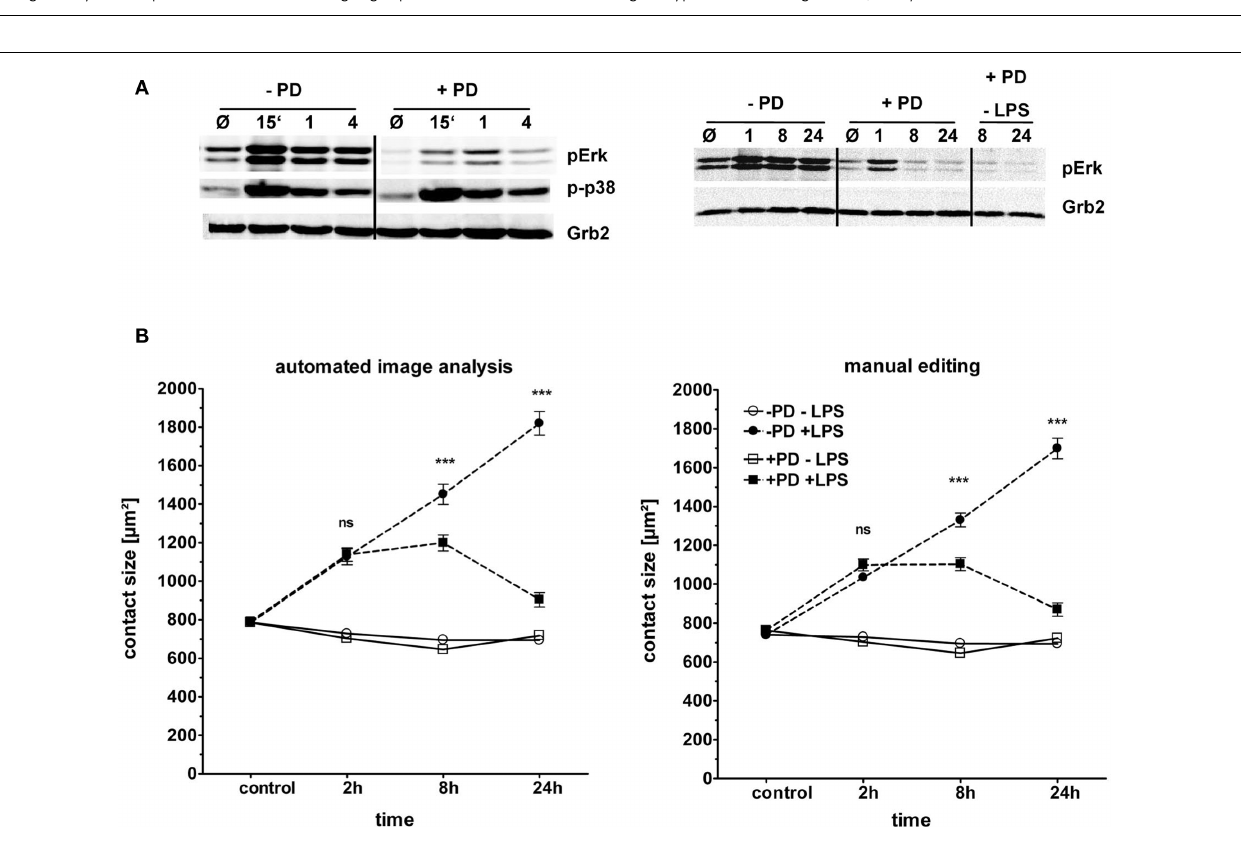
FIGURE 5 | Phenotype of Myd88 − / − macrophages in cell spreading. BMM from Myd88 ± and Myd88 − / − mice were plated and stimulated as described in Figure 3 . Macrophage spreading was analyzed by automated image analysis (left panel) and manual editing (right panel). Shown are mean